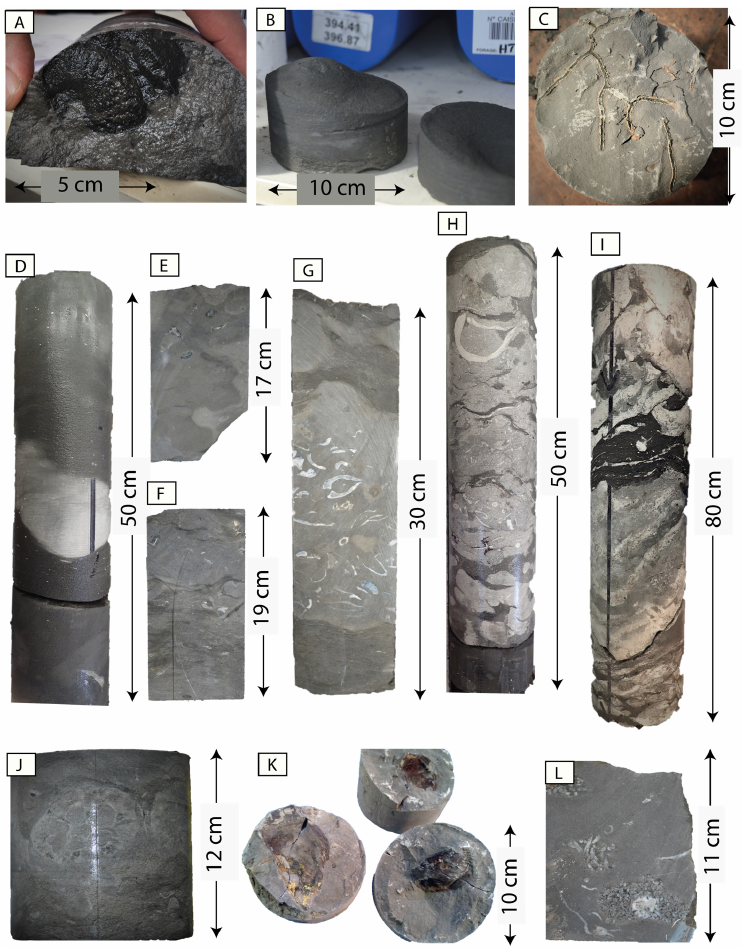
Figure 4. Photographs of notable sedimentological observations and illustrations of facies associations. ( A ) Ammonites observed in lithofacies F2.1, well EST433, − 556 m; ( B ) Asymmetrical ripple observed in lithofacies F2.1, well HTM 102, − 395.2 m; ( C ) Lithofacies F2.1: silty calcareous claystone with bioturbations of Chondrites type, well EST322, − 548.65 m; ( D ) Lithofacies F4.4: marlstone with a micritic calcareous nodule showing diagenetic calcite precipitation at its border; well EST423, − 403.5 m; ( E ) Bioturbated argillaceous limestone with dissolved oyster shells and silicified serpulids (lithofacies F5.6, BI = 2) ( F ) Bioturbated argillaceous limestone (lithofacies F5.1, BI = 5); ( G ) Lithofacies F6.2 showing a floatstone level containing recrystallised bivalve shells and serpulids, filled with celestine, silica and calcite; well EST433, − 562.4 m; ( H ) Lithofacies F6.3: floatstone containing bivalve shells (amongst which Gryphea ) and numerous gastropods ( Nerinea ), well EST 413, − 402.7 m; ( I ) Lithofacies F6.4: platy coral in life position, well EST413, − 401.8 m; ( J ) Lithofacies F6.4: floatstone with reworked massive corals, well EST205, − 425.75 m; ( K ) Lithofacies F2.2: calcareous claystone showing the superposition of three Mitilidae in life position, well EST322, − 519.2 m; ( L ); Clayey limestone of lithofacies F5.3 affected by Thalassinoides bioturbations, which are infilled by a crinoidal packstone (lithofacies F5.5), well HTM102, − 341.8